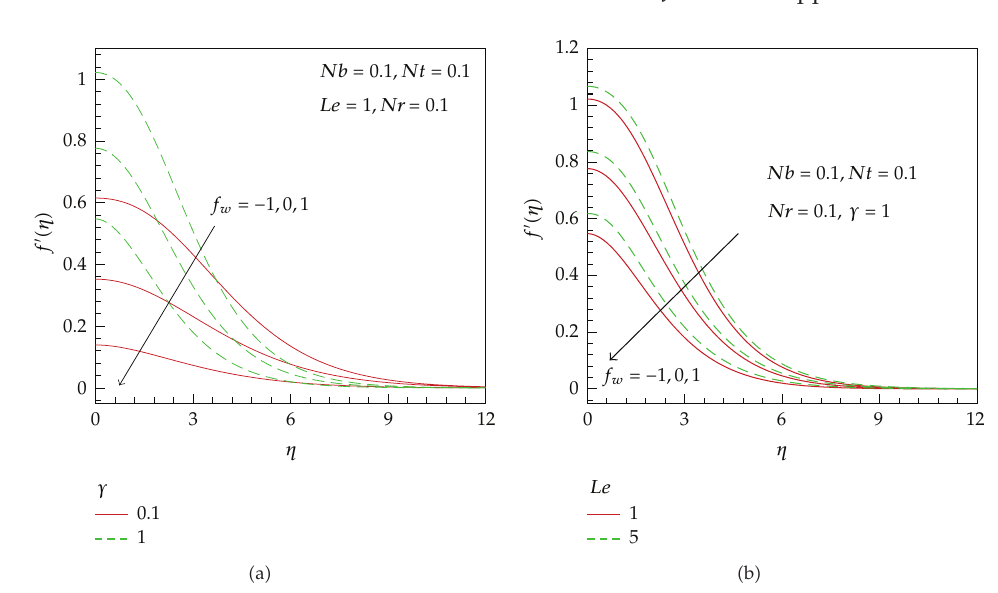
Figure 3: E ff ect of (cid:3) a (cid:4) Biot number, (cid:3) b (cid:4) Lewis number on the dimensionless velocity for di ff erent values of suction/injection